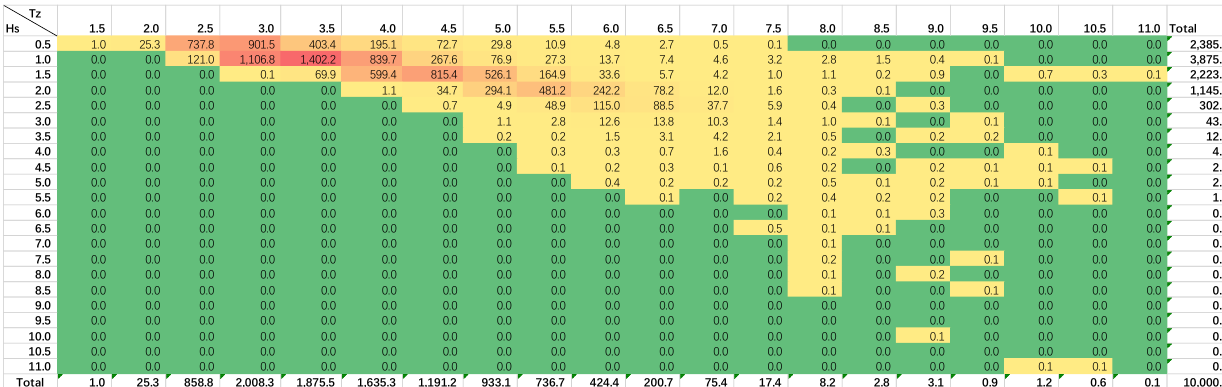
Figure 19. Wave scatter diagram at Site F. Figure 20 shows rose plots of the H s and mean wave direction for the characteristic sites. It can be seen that the main wave directions at the three characteristic sites of the Xuande Atoll were all in the N-E direction, while Island A and Island B were also under the influence of waves from the SSE direction. The directional distributions of waves near the different sites of the Yongle Atoll were quite different. The main wave direction at the Island D site was the N-E direction. Meanwhile, as Island E is inside the Yongle Atoll lagoon, there was no obvious main wave direction. The wave directions with a higher frequency at Island E were NNW and S. Island F was dominated by the waves from the E